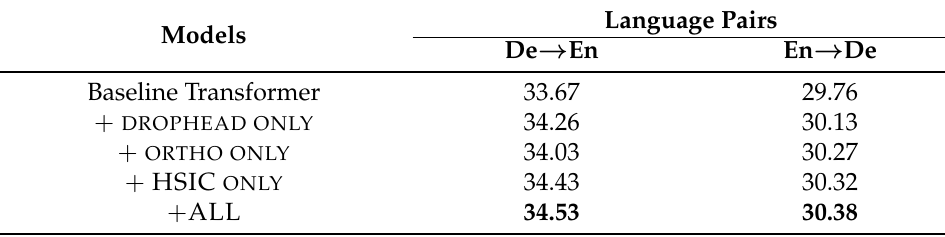
Table 4. BLEU evaluation with controlled inter-head similarity on En-De IWSLT17 corpus.